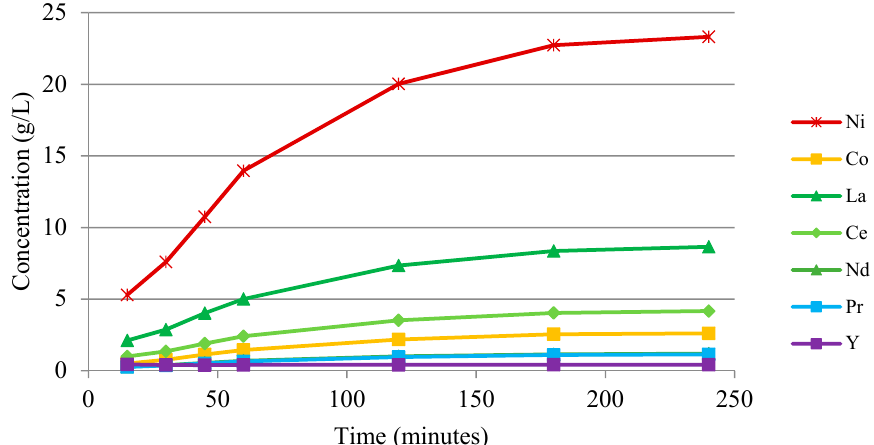
Figure 2. Leaching of anode material with 1 mol/L sulfuric acid at 25 °C (Exp. 1A).